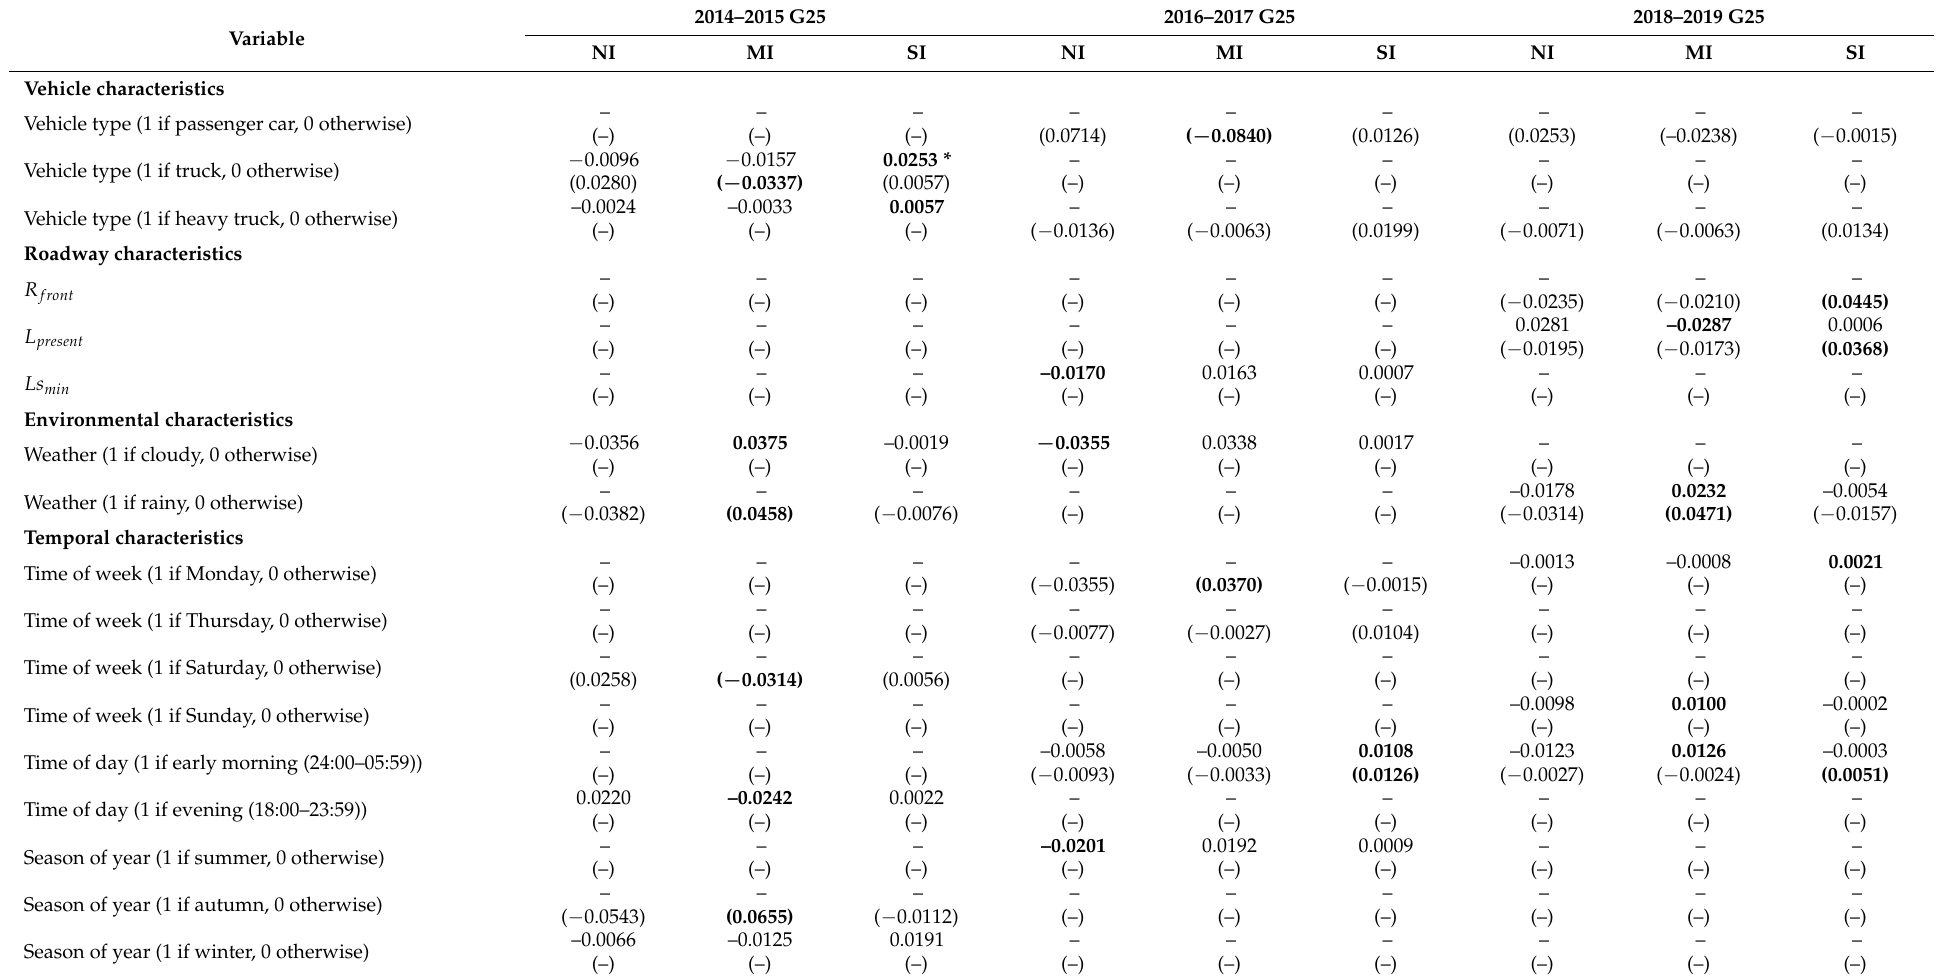
Table 7. The marginal effects of contributing factors in two-vehicle and multi-vehicle rear-end crashes (effects of multi-vehicle model in parentheses) for Changchun- Shenzhen Freeway (G25)